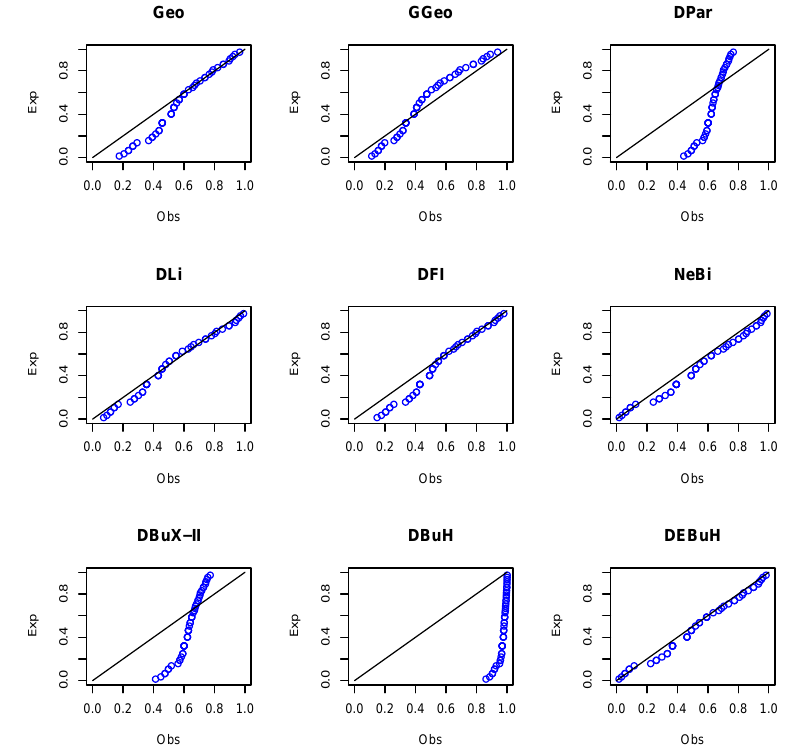
Figure 10. The PP plots of the fitted models for data set II.